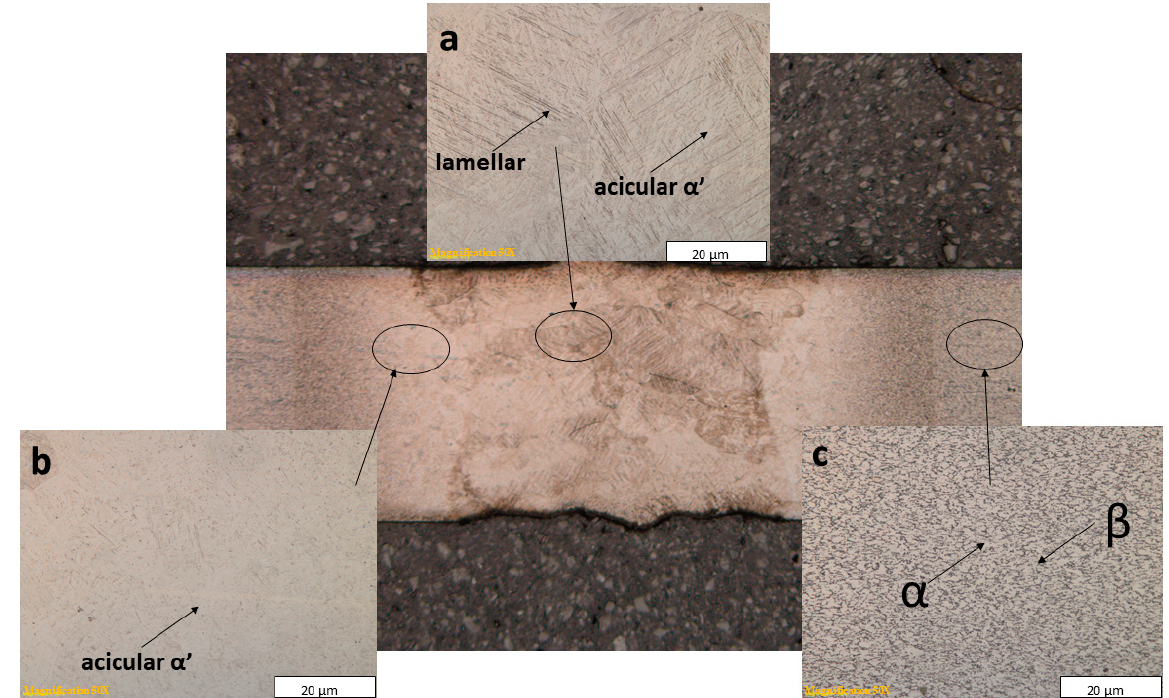
Figure 3. Micrographs of laser-welded joint. ( a ) Fusion zone; ( b ) Heat affected zone; ( c ) Base metal.